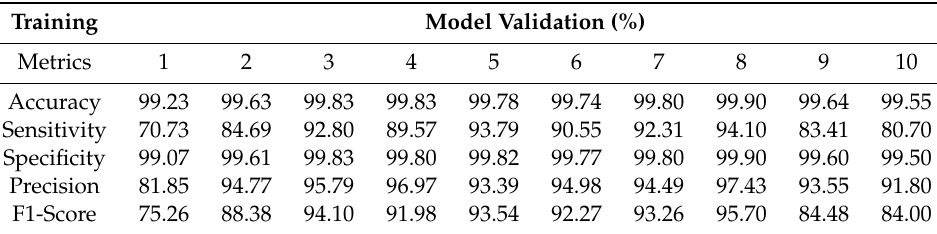
Table 4. Training performances based on 10 models.